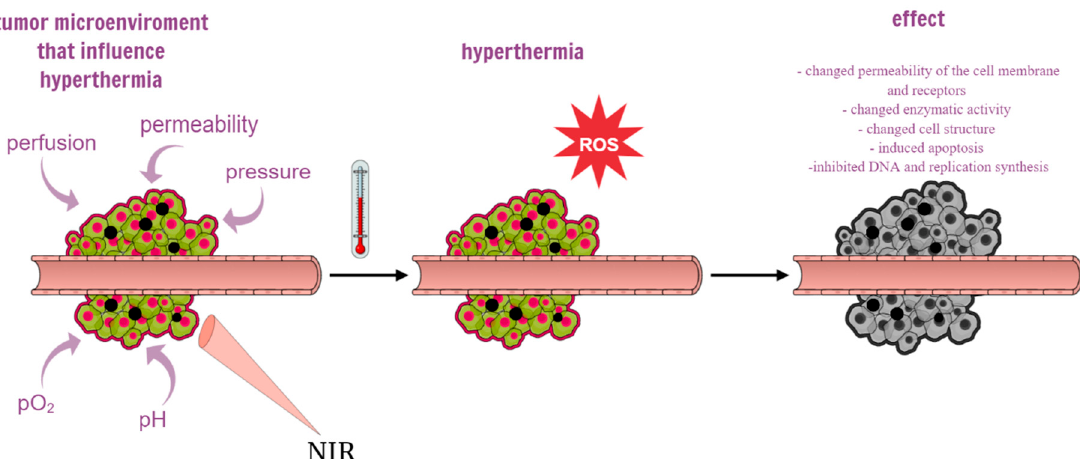
Figure 3. The diagram shows the influence of the tumor microenvironment on hypothermia and the effects of photothermal therapy mediated by polydopamine-based nanoparticles. A large amount of gold nanoparticles accumulates in cancer cells, which causes a photothermal effect in response to near-infrared light (NIR) and reactive oxygen species (ROS), ultimately inducing apoptosis and ne- crosis of cancer